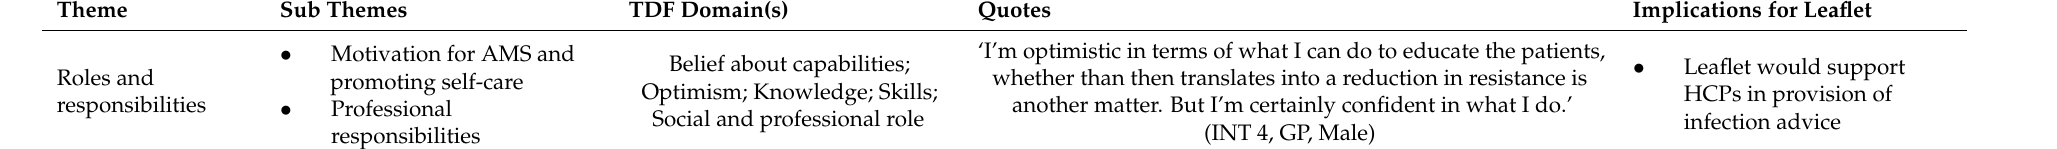
Table 3. Emerging themes of healthcare professionals on provision of advice to patients with common